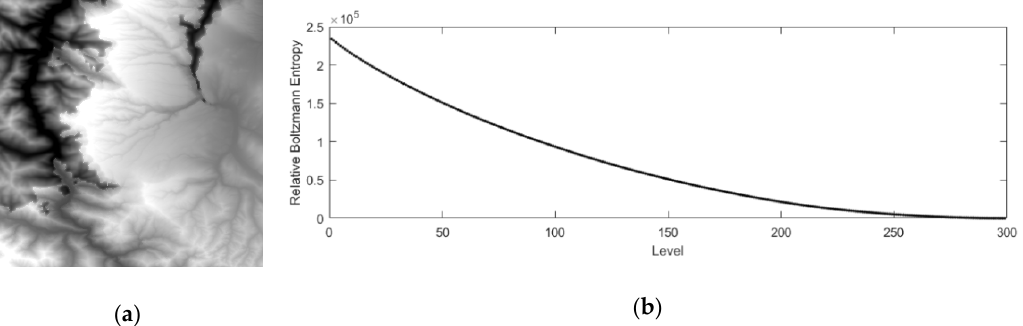
Figure 4. An illustration of ( a ) a Digital Elevation Model (DEM) obtained from the Geospatial Data Cloud site (http: // www.gscloud.cn) with a size of 300 × 300 pixels, and ( b ) a curve established between Cloud site (http://www.gscloud.cn) with a size of 300 (cid:3400) 300 pixels, and ( b ) a curve established the hierarchy level of the DEM and its relative Boltzmann between the hierarchy level of the DEM and its relative Boltzmann entropy.